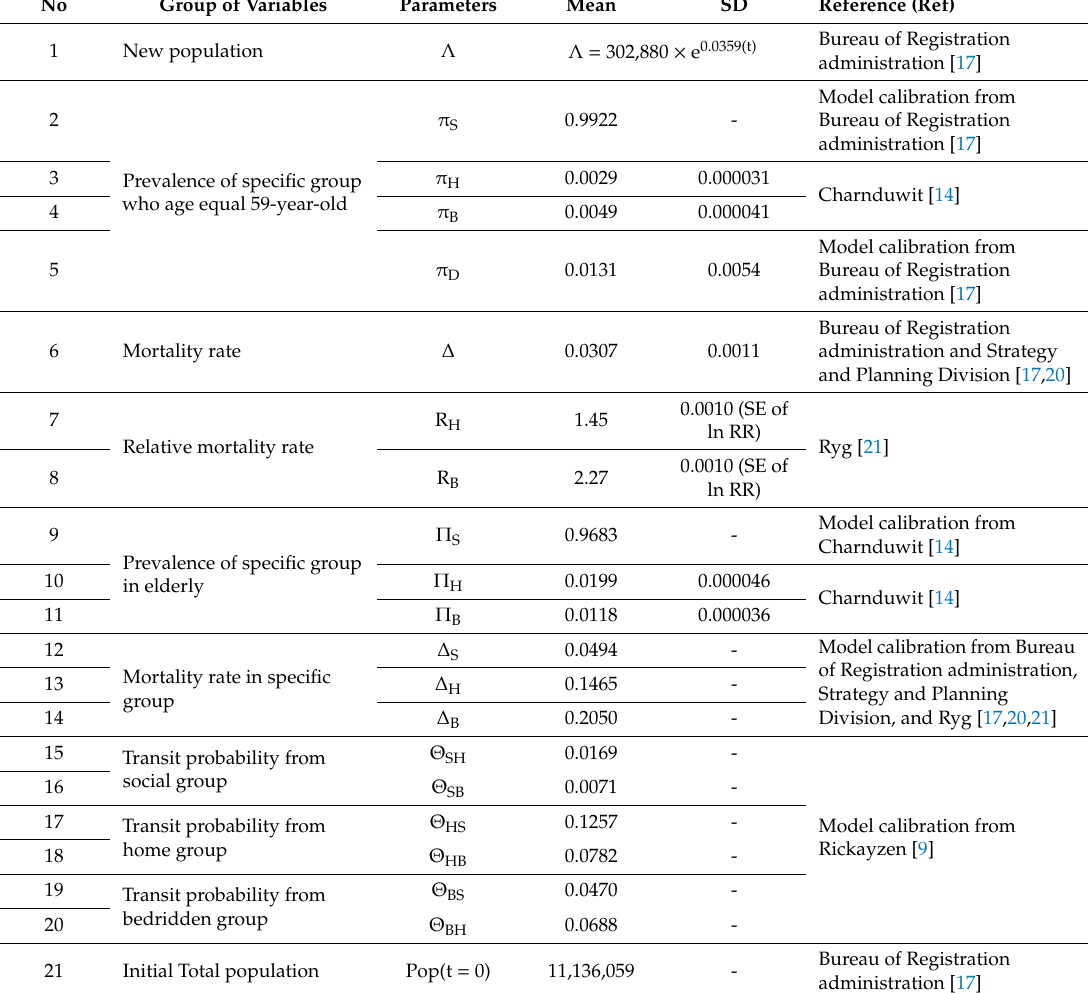
Table 6. Summary of parameters used for projecting the amount of bedridden